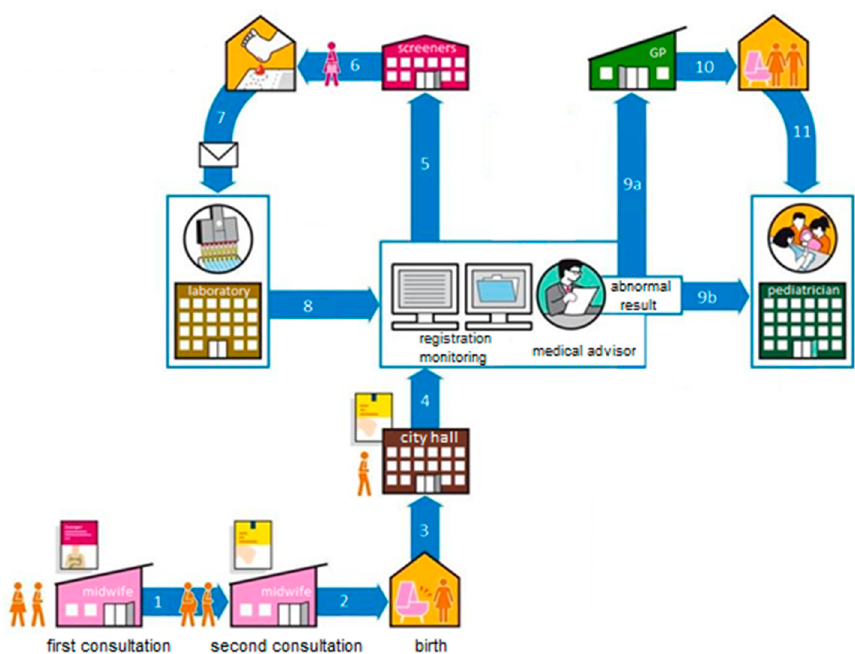
Figure 1. The primary process of the Dutch newborn screening program. Expecting parents will receive information about the newborn screening program during the first [1] and second consultation with the midwife [2]. The first information brochure briefly mentions newborn screening, whereas the second brochure elaborates on the objectives, disorders and newborn screening process. During registration of a newborn at city hall, the second information brochure will be handed out as well (3). The screening organisations (5) will be informed about the registration of the newborn at city hall (4), after which screeners will visit the parents at home or in the hospital (6). They will perform the heel prick and send the heel prick card by post to one of the five screening